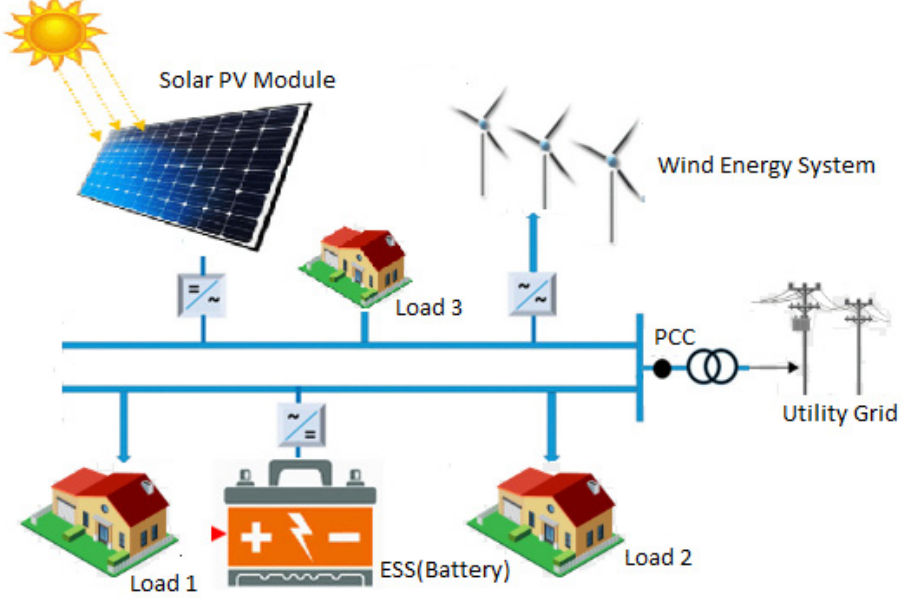
Figure 2. Hybrid DC/AC microgrid System.